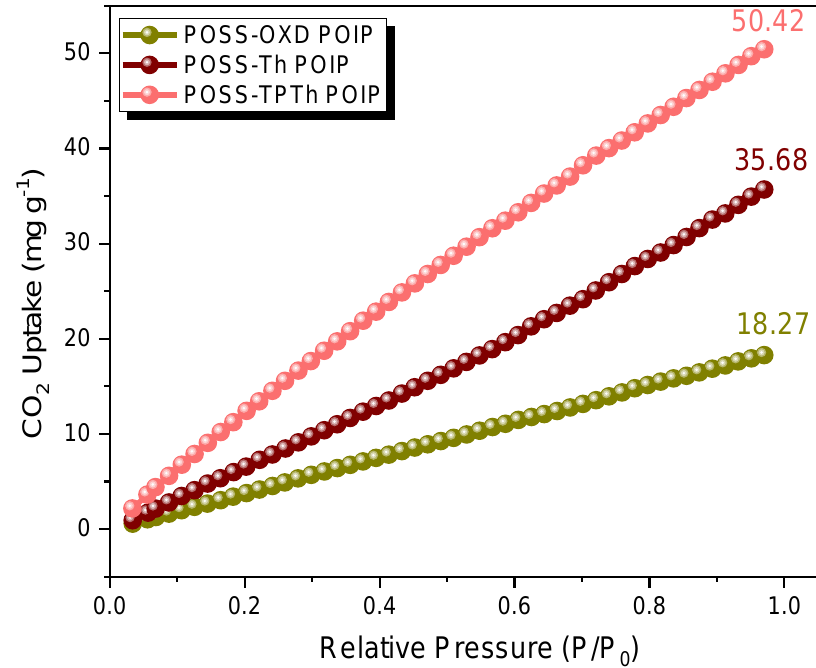
Figure 6. CO 2 uptake capacities of the POSS-OXD, POSS-Th, and POSS-TPTh POIPs.